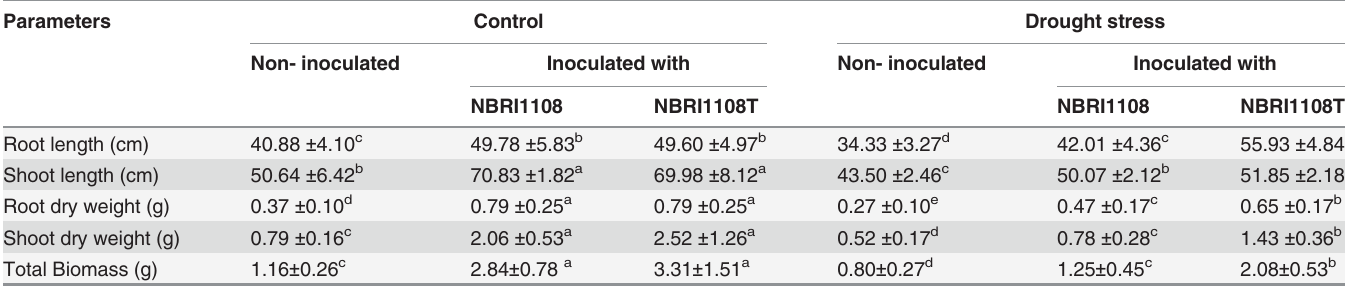
Table 3. Effect of inoculation of P. putida NBRI1108 and NBRI1108T on the growth of maize plant in drought stress.